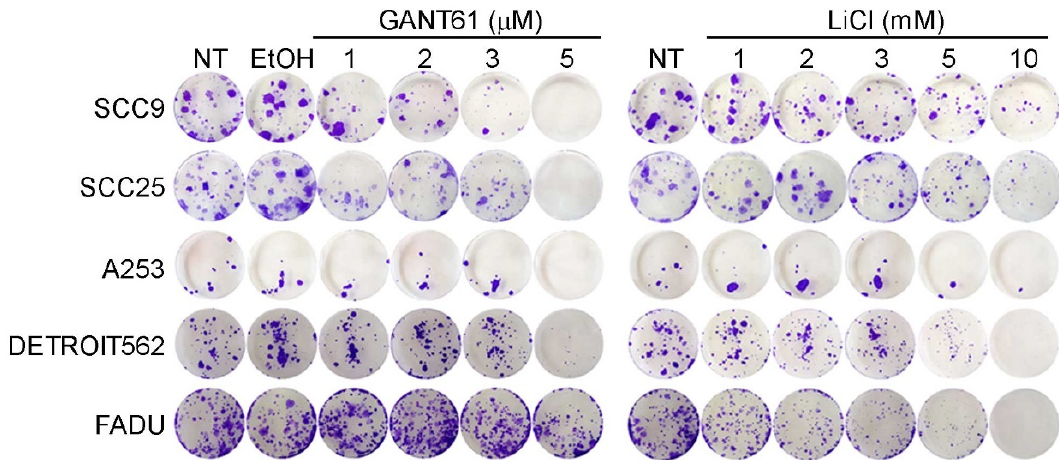
Figure 5. Colony forming assay on HNSCC cell lines. All cell lines show a dose-dependent decrease in colony forming ability with both GANT61 and LiCl. EtOH – vehicle control.